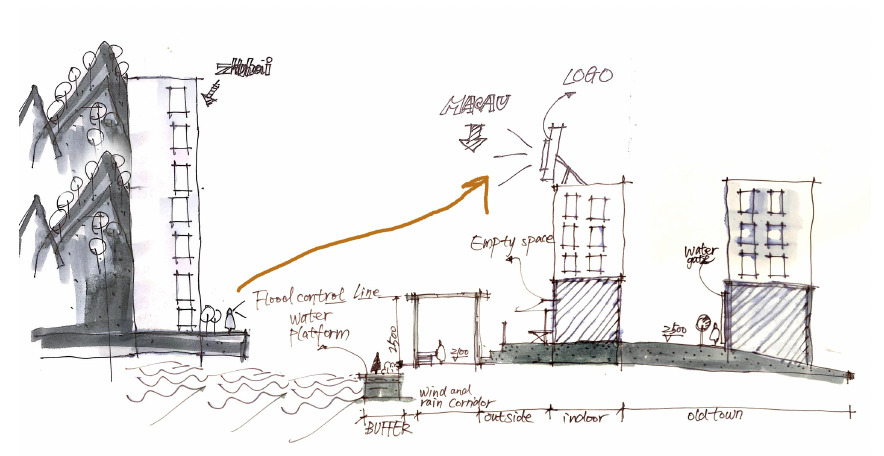
Fig. 7 Draft overall design concept for the Inner Harbour coast